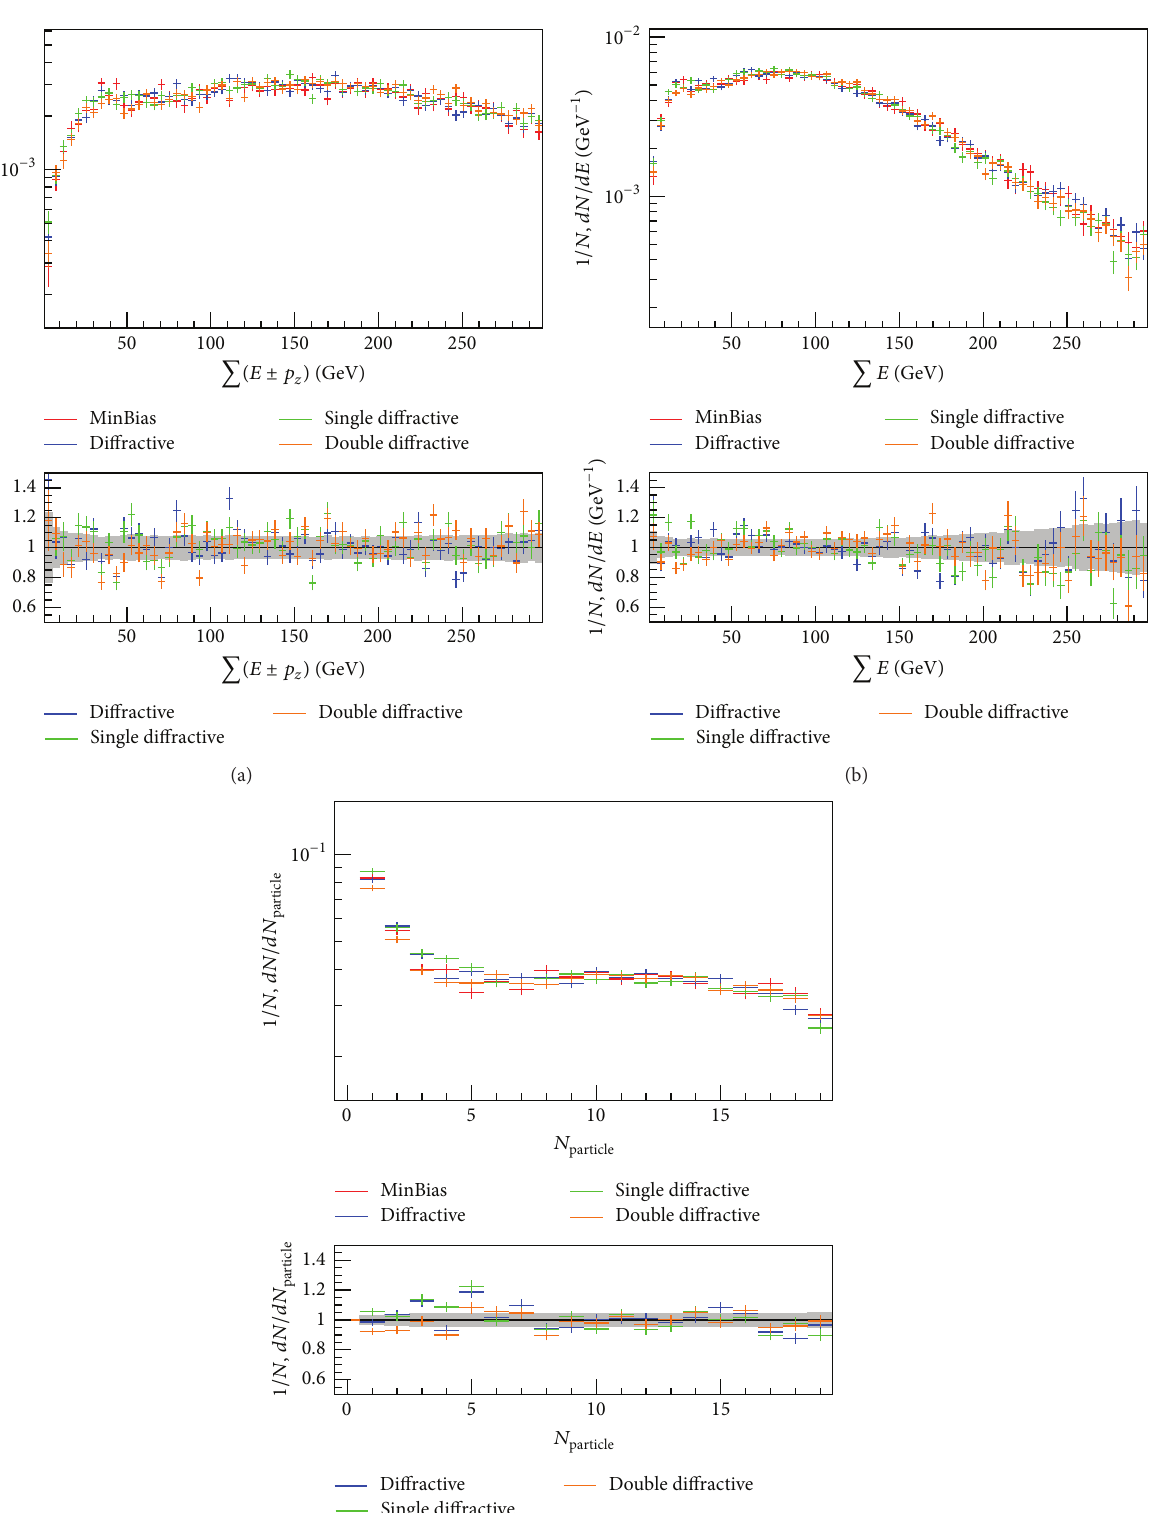
Figure 10: Distributions of ∑(𝐸±𝑝 𝑧 ) (a), total energy deposition (b), and particle multiplicity (c) for the events that have an edge gap Δ𝜂 > 3 with a 𝑝 T > 200 MeV cut on final state particles in |𝜂| < 5.2 . The distributions are normalized to the number of events, N , that pass the analysis cuts. The MinBias event class is used as a reference for the